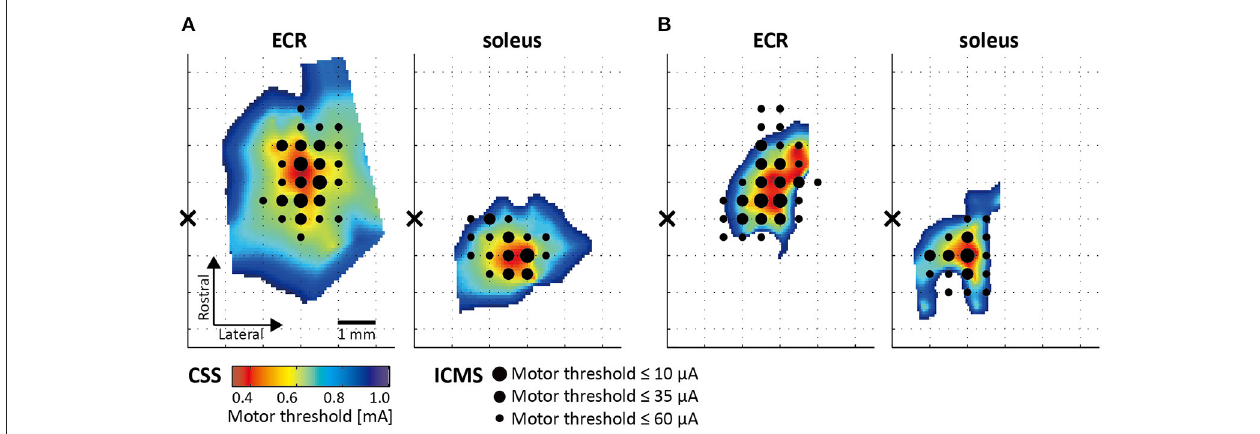
FIGURE 4 | Motor maps assessed using CSS and intracortical microstimulation (ICMS). Topographical spatially interpolated motor maps obtained from two rats (A,B) . Color scale reflects the MT assessed by CSS, black dot size reflects the MT assessed by ICMS. Black cross represents the position of the bregma.